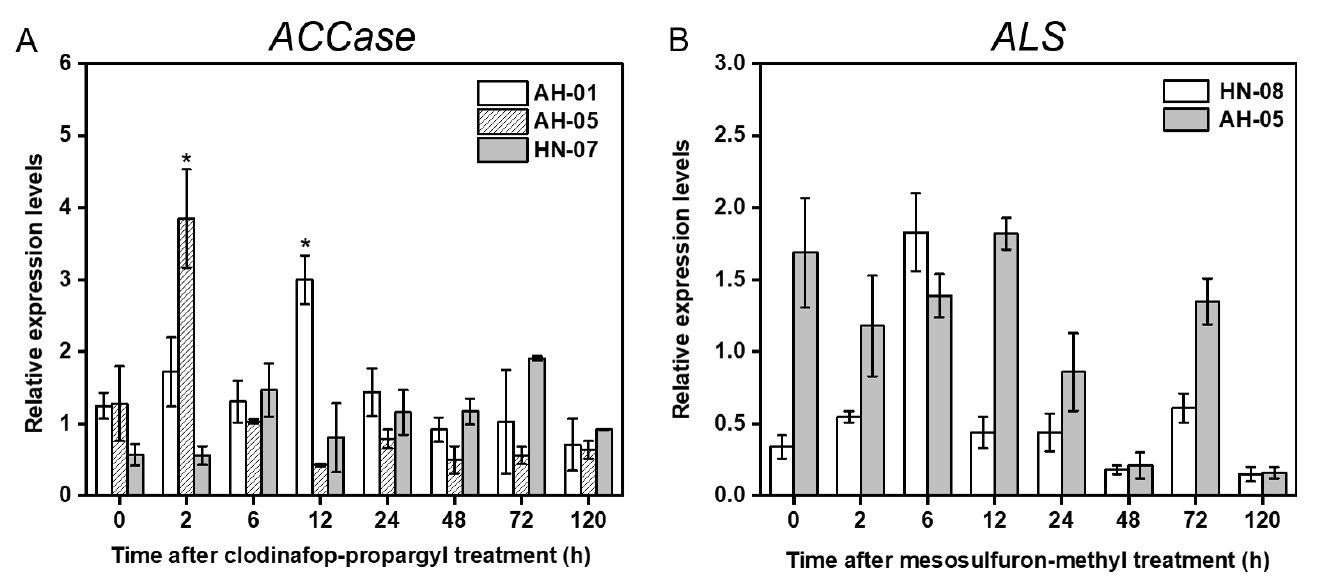
Figure 3. Relative expression levels of ( A ) ACCase and ( B ) ALS in ACCase- and ALS-resistant L. multiflorum plants at 0 (control), 2, 6, 12, 24, 48, 72, and 120 h after clodinafop-propargyl or mesosulfuron-methyl treatment, respectively. Asterisk indicates significant upregulation (fold change ≥ 2 and p < 0.05) of target gene in resistant plants compared with the susceptible plants (AH-07). Table 7. The GR 50 values a and Rls b of susceptible (AH-07) and resistant (AH-01, AH-05, and HN-07) populations of L. multiflorum to different